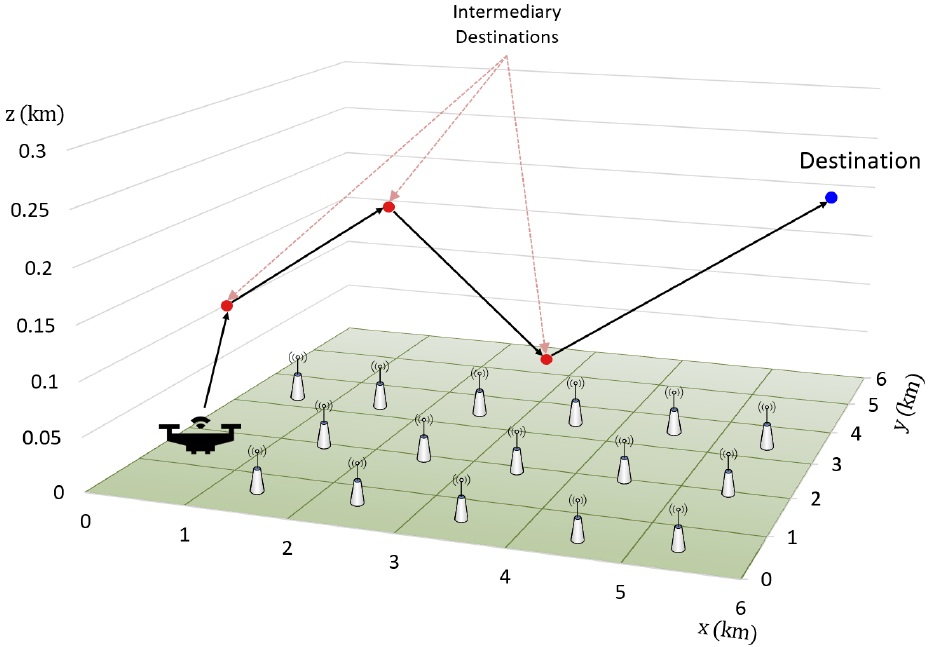
Figure 4. UAV movement in a UHD environment using a Random Way Point (RWP) mobility